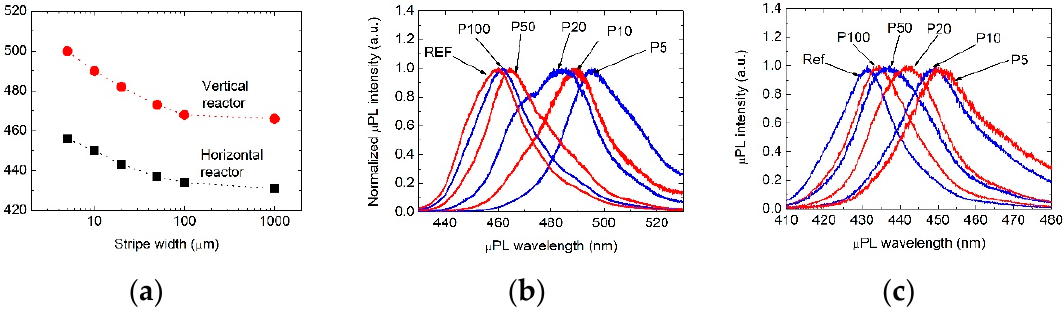
Figure 3. Micro-photoluminescence ( µ PL) of nominally identical InGaN / GaN structures grown on substrates with 4 µ m high stripes using vertical and horizontal reactors. ( a ) Central wavelength of µ PL as a function of stripe width, ( b ) normalized µ PL spectra of structure grown using a vertical reactor, ( c ) normalized µ PL spectra of structure grown using a horizontal reactor.